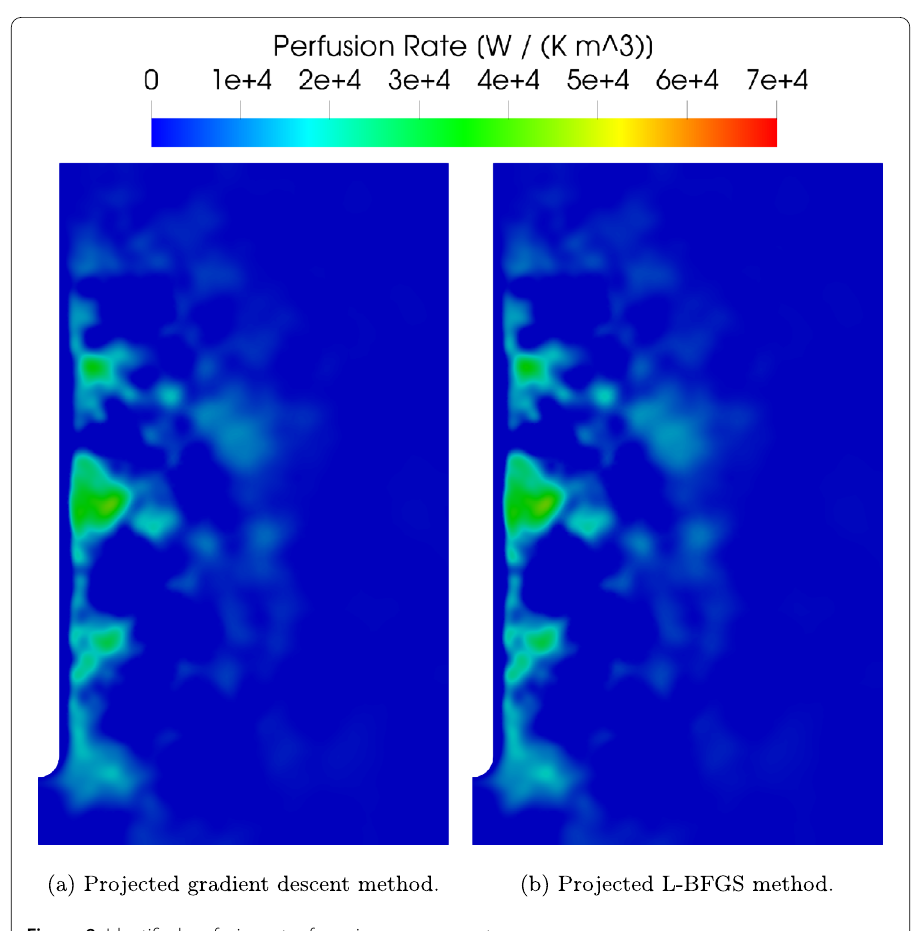
Figure 8 Identified perfusion rates for noisy